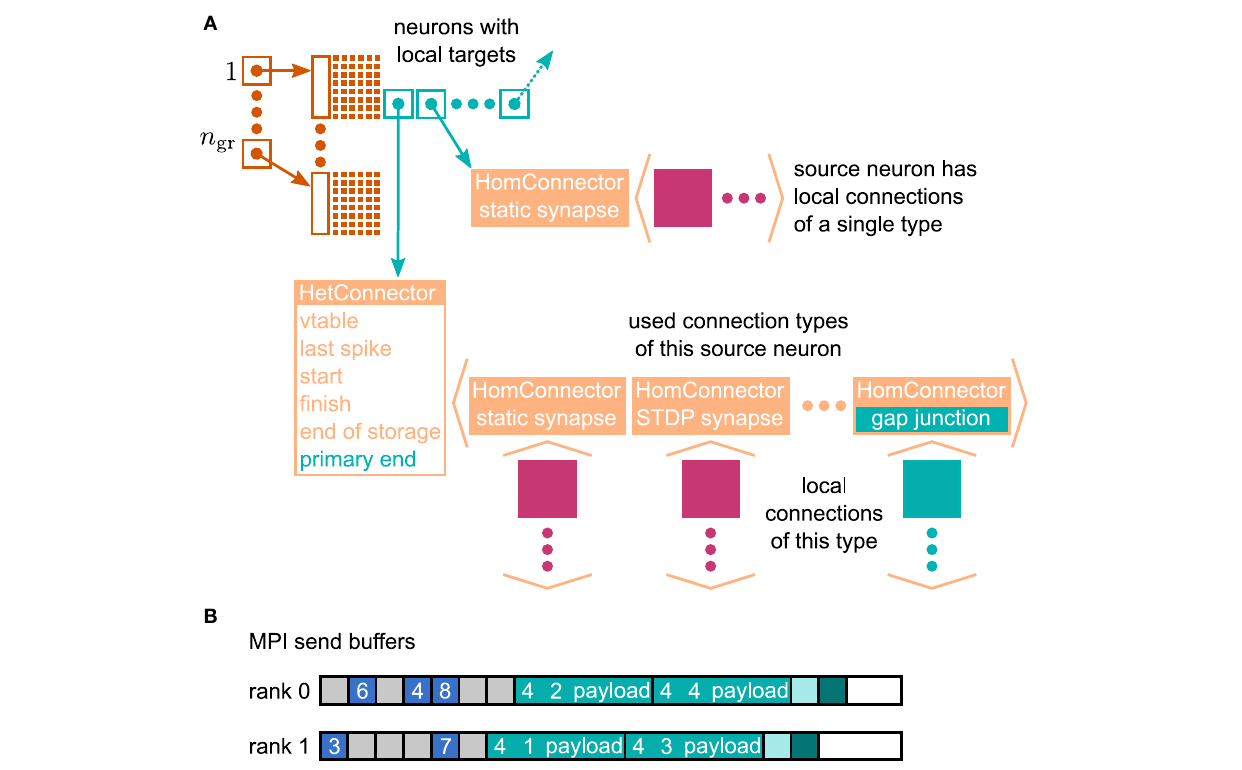
FIGURE 4 | Data structures for the representation of gap junctions. Turquoise elements indicate necessary changes to the fundamental data structures with respect to the 4g simulation kernel of NEST (cf. Kunkel et al., 2014). (A) Thread-local connection infrastructure. For all neurons a sparse table (dark orange) encodes whether at least one thread-local target is present or not. If a neuron has local targets, the sparse table stores a pointer (turquoise square with arrow) to a connection container (light orange data structure), where the least significant bits of this pointer encode whether gap junctions are present or not. The container is either a HomConnector or a HetConnector depending on whether the neuron has only one or more than one type of local connection. A HomConnector directly stores the connection objects, whereas a HetConnector stores a vector of HomConnector s, one per connection type. The HomConnector s for spiking connections come first in the vector and the member primary_end is the number of spiking connection types in the vector . (B) MPI send buffers accumulating outgoing events in the scheduler. Toy example for a particular communication interval with two MPI processes, where rank 0 hosts the neurons with even global IDs (GIDs) and rank 1 hosts the neurons with odd GIDs. Each buffer consists of two parts: the data related to spiking connections (blue boxes) followed by the data related to gap junctions (turquoise boxes). The spike data consist of the GIDs of the local neurons that spiked in the last communication interval, where markers (light gray boxes) define the end of a simulation interval (here four simulation steps per communication step) and thereby encode the spike time. For each local neuron that has gap junctions (here neurons 1–4) the corresponding buffer contains an entry, which consists of the ID of the connection type (here gap junctions have the ID 4), the GID of the neuron, and information about the state of the neuron (payload). A marker (light turquoise box) defines the end of the gap-junction data. The final valid entry in each buffer is a boolean value (dark turquoise box), which encodes whether the local neurons require another iteration of the waveform-relaxation method. The buffers may not be completely filled (white